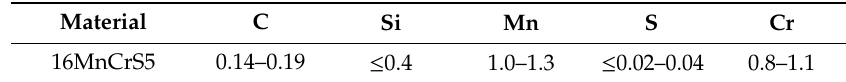
Table 1. Chemical composition of the investigated low alloyed case hardening steel 16MnCrS5, in wt%